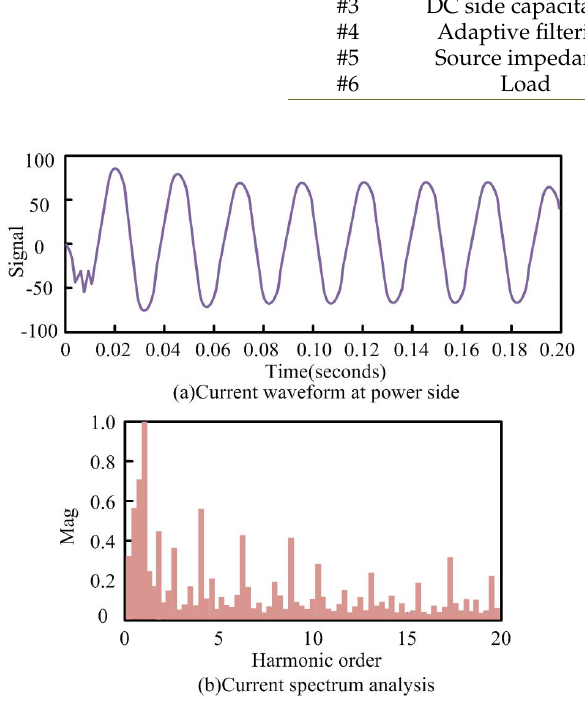
Fig. 7. Analysis of power supply current waveform and current spectrum obtained by optimal control method